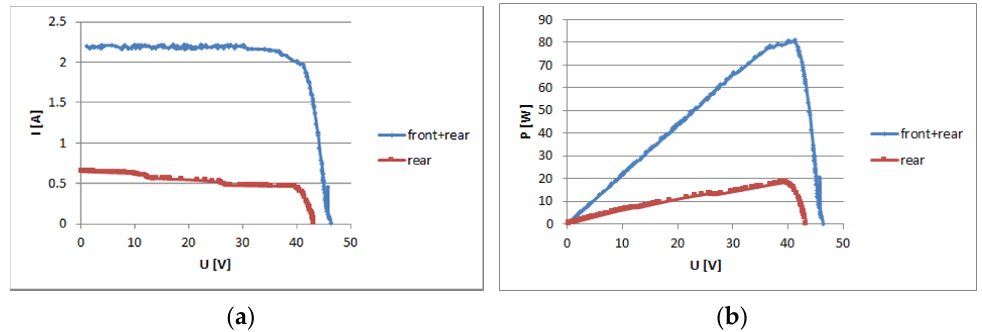
Figure 13. The whole vs. rear side yield characteristics benchmark in a bifacial module: ( a ) current- voltage characteristics; ( b ) power-voltage characteristics for 75° inclination, over the white substrates.